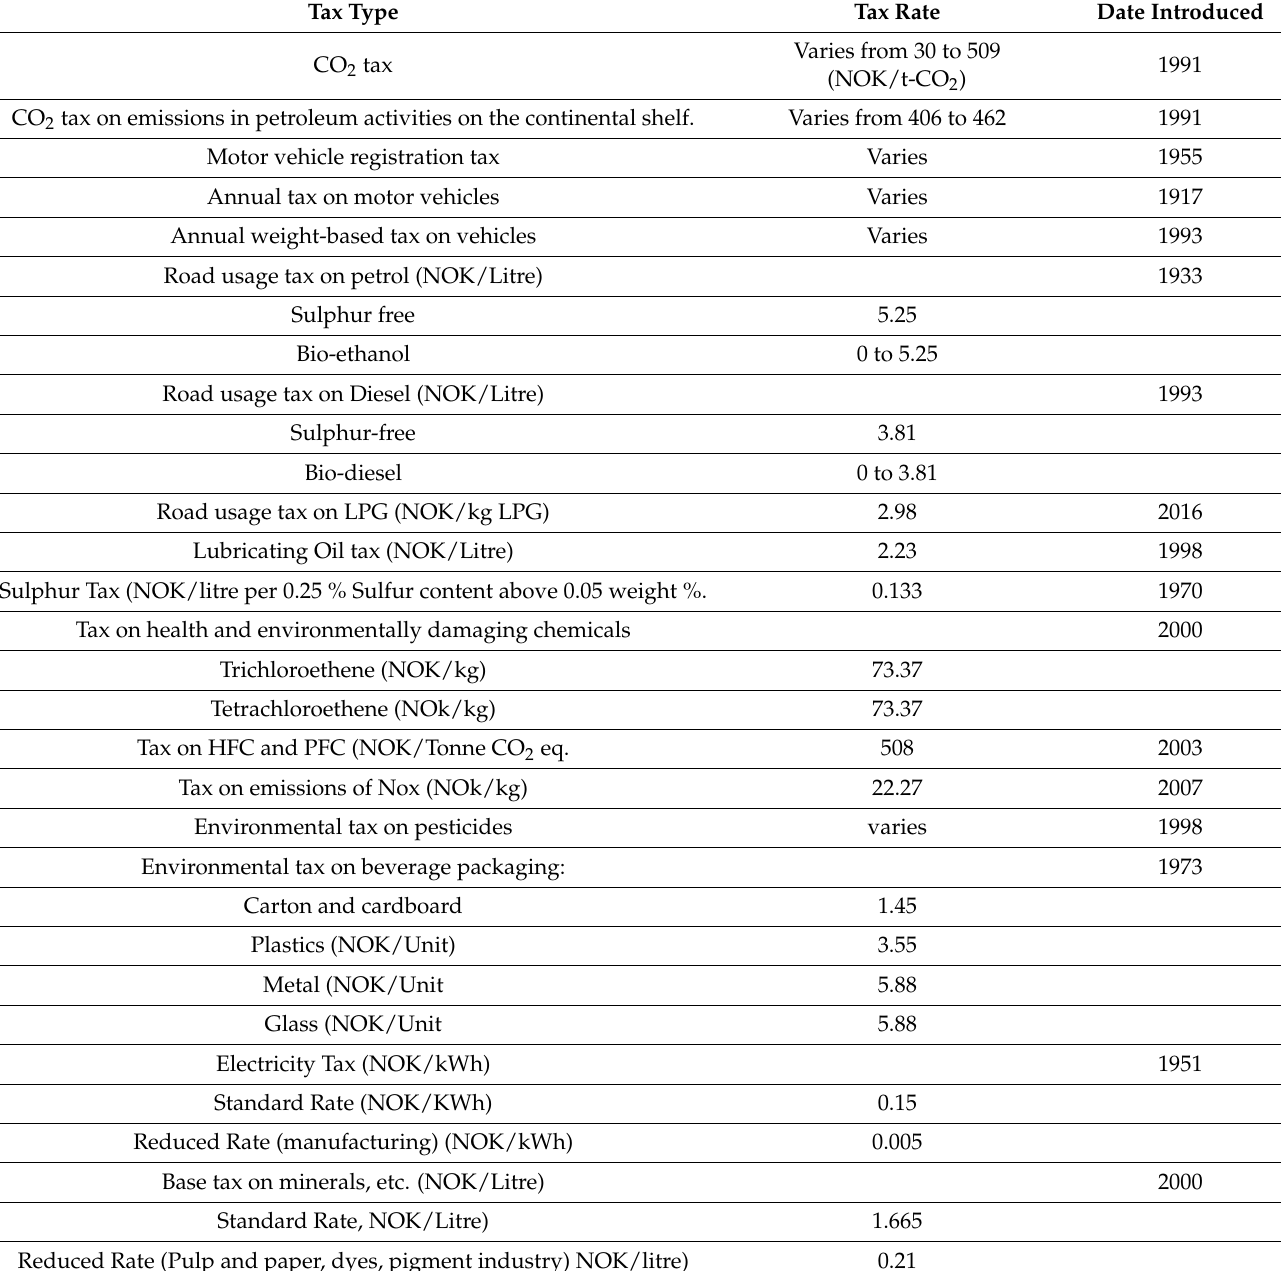
Table 11. Norwegian Green Taxes. Source: [53] Norway Ministry of Climate and Environment